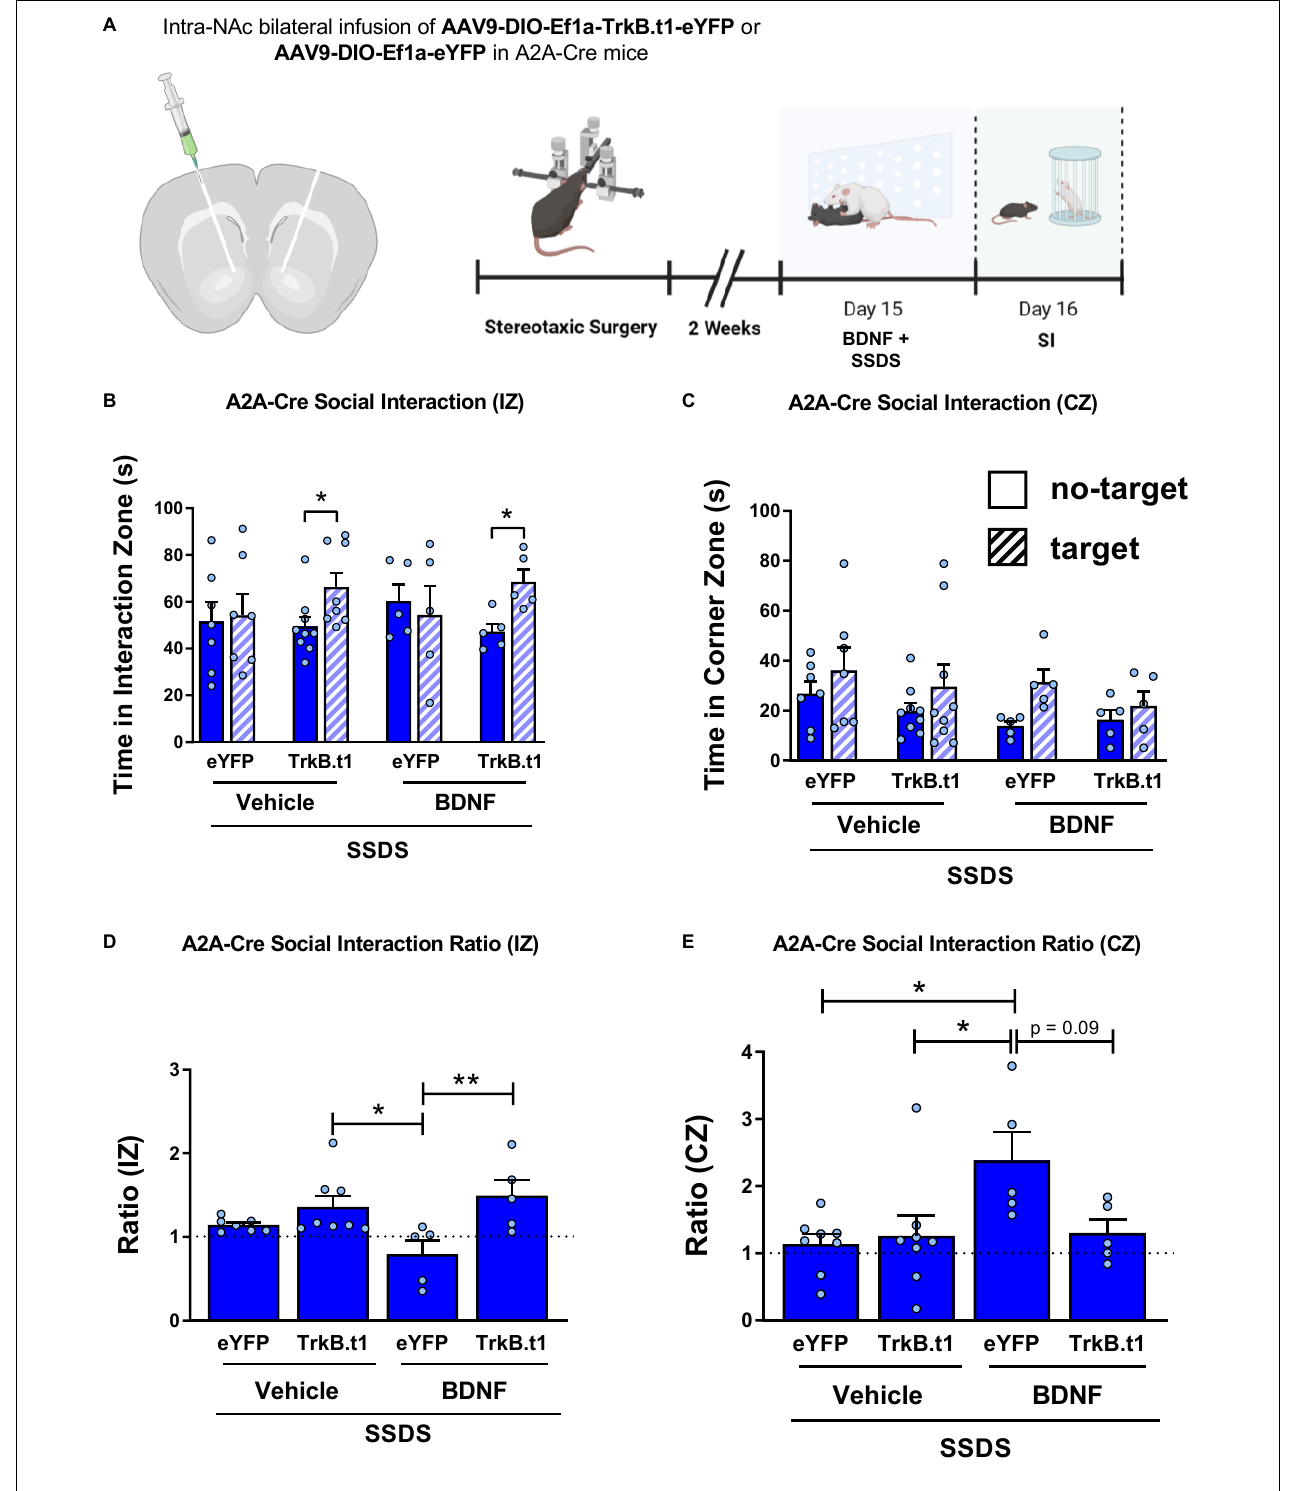
FIGURE 6 | Blocking BDNF-TrkB signaling in D2-MSNs prevents the intra-NAc BDNF infusion-induced stress susceptibility in male mice. (A) Illustration of the viral injection site, the viral vectors used in this experiment (with cannula implantation), and the experimental design. (B) TrkB.t1 expression in D2-MSNs increased social interaction even after BDNF infusion and SSDS. (C) TrkB.t1 expression in D2-MSNs blocked BDNF-induced increase in corner zone preference after SSDS during the social interaction test. (D) Social interaction ratio in the interaction zone and in the (E) corner zone, showing that only SSDS-BDNF-eYFP mice showed a susceptible phenotype as previously described ( N = 5–9 per group; * p ≤ 0.05; ** p ≤ 0.01; SI, social interaction test; SSDS, subthreshold social defeat stress).